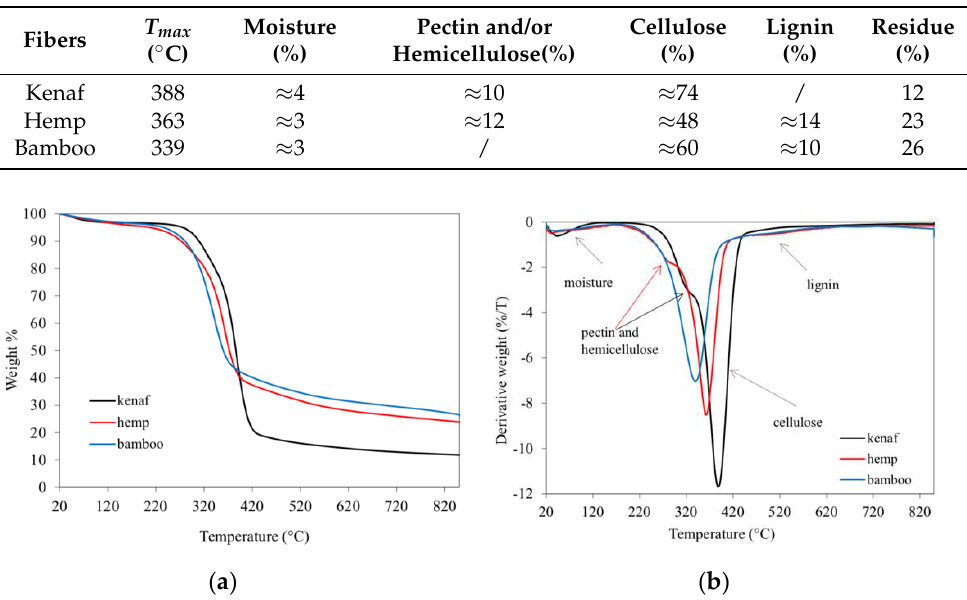
Table 2. TGA data of the fibers.